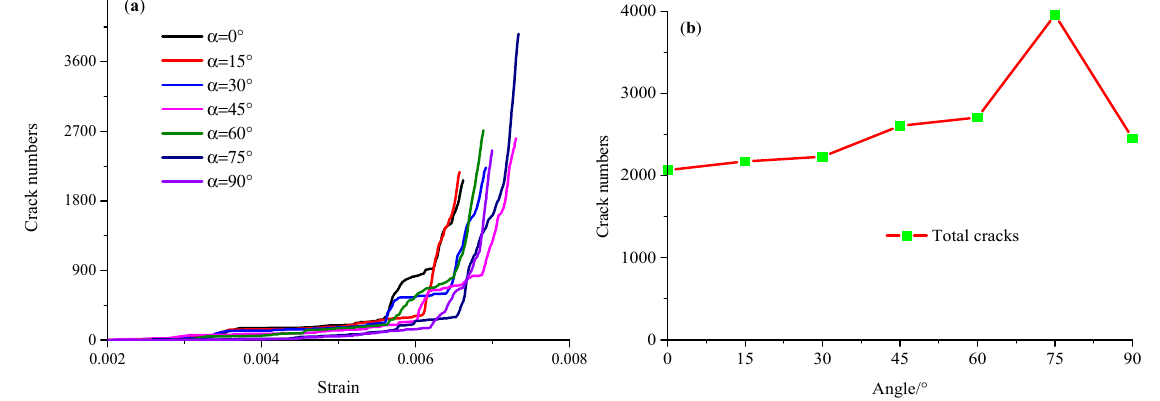
Figure 8. Numbers of strain crack per model and the total cracks in numerical models with different angles of prefabricated cracks. ( a ) The number of strain cracks in different defect combination models. ( b ) The total number of cracks.